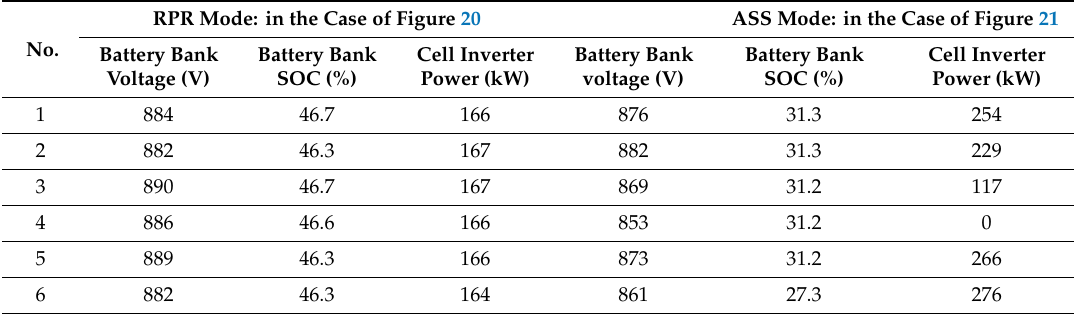
Table 5. Battery and Cell Inverter Status Data by Mode in Figures 20 and